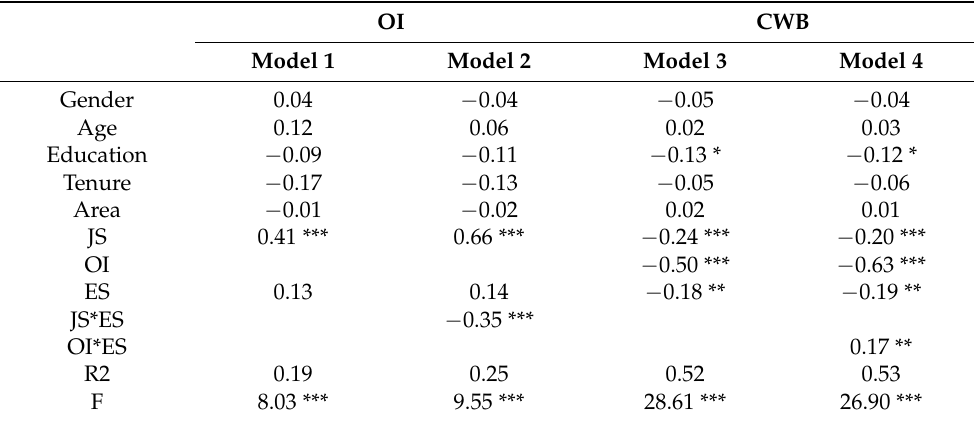
Table 4. Moderating effects of employment